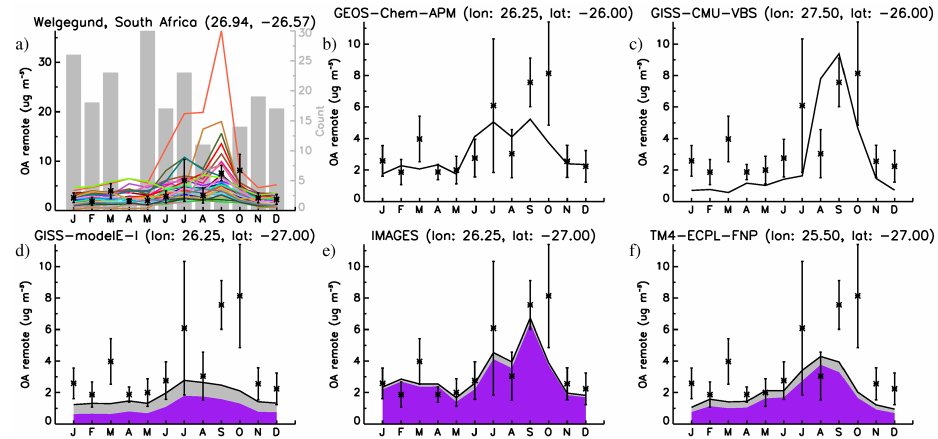
Figure 20. Same as in Fig. 18, for OA at Welgegund, South Africa (remote, years 2010–2011). The chemical composition in (b–f) (where available) is presented as defined by the AMS: HOA (grey) and OOA